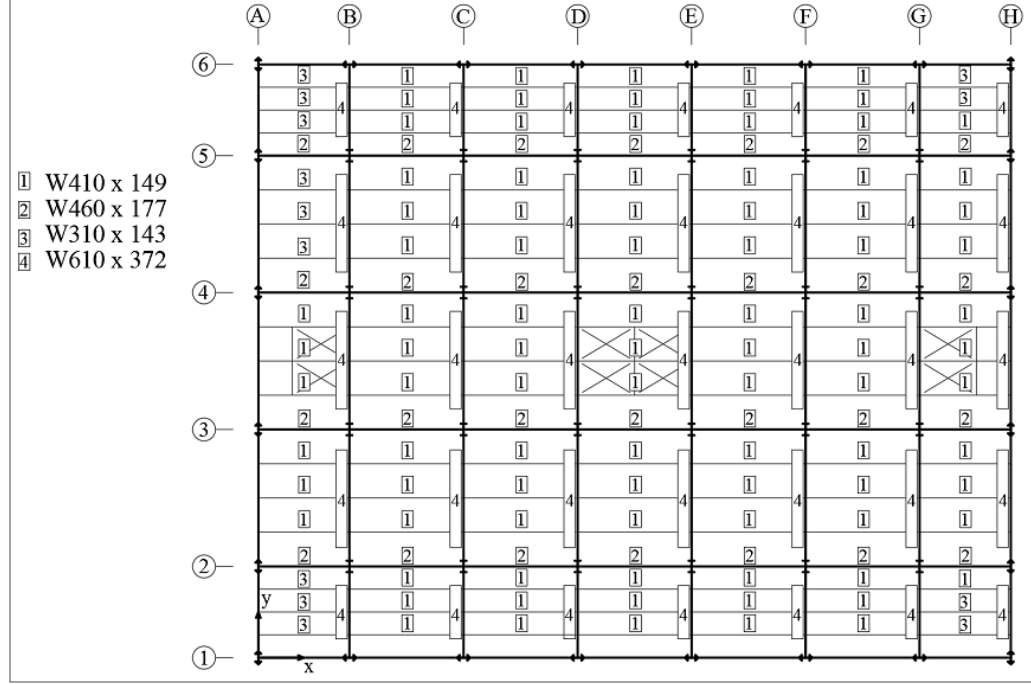
Figure 5. Designed sections for internal beams at all floor levels.